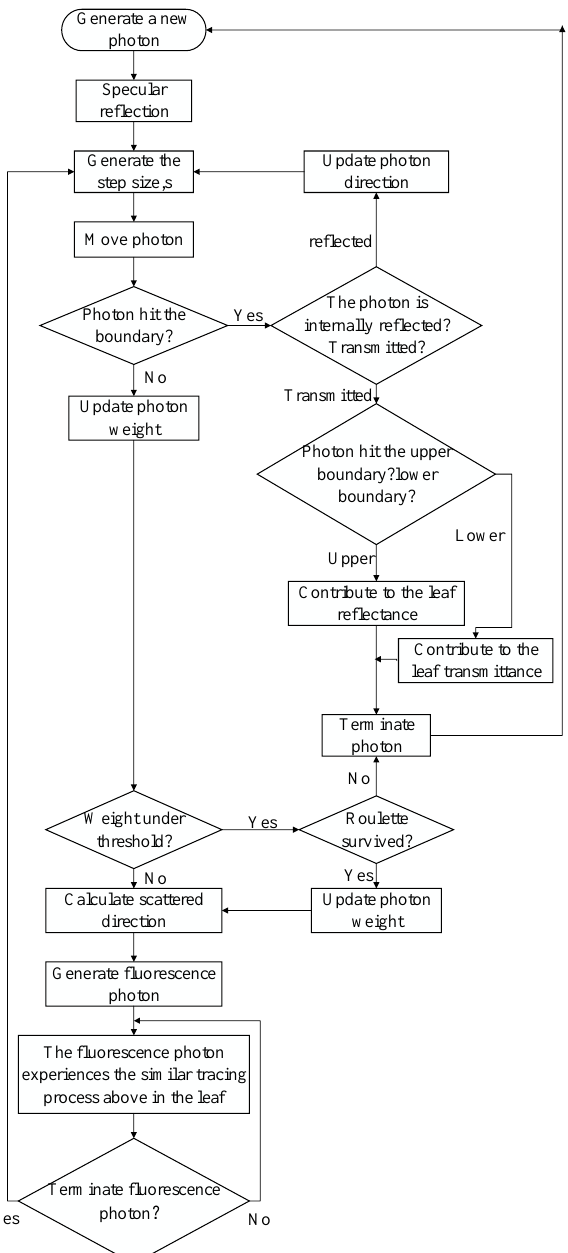
Figure 2. Flowchart of the MC model for the simulation of RT for a